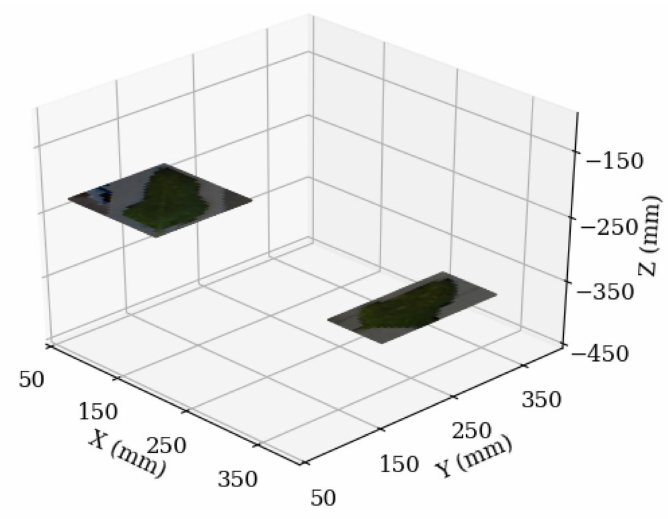
Figure 13. 3D digital reconstruction of the leaves seen in Figure 6. Creating this graph demonstrates that the functionality of leaf position estimation could run from end to end with no